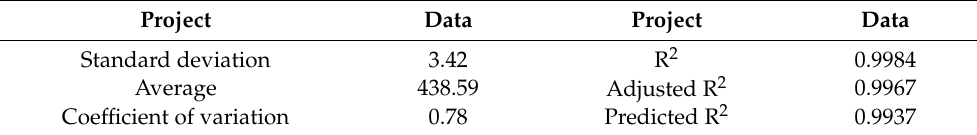
Table 2. Results of the reliability analysis from the response surface test.